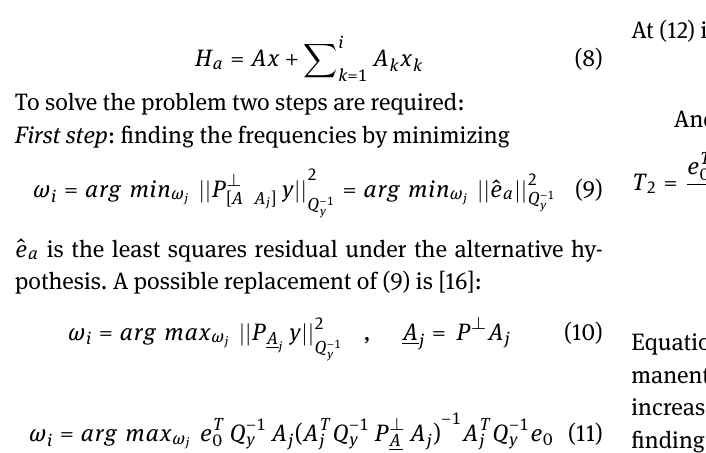
Figure 7: New time series of parameter X for station (a) GRAZ, (b) ONSA, (c) WSRT.